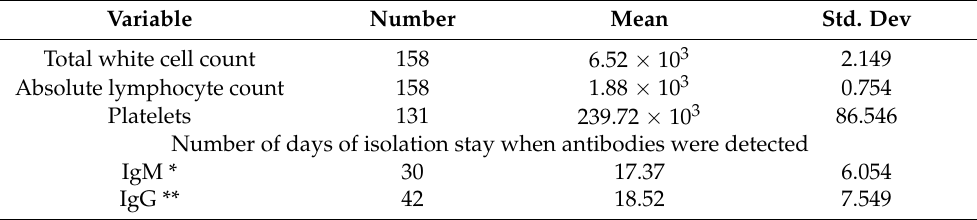
Table 2. Haematological and serological data of COVID-19 patients in Phuentsholing. Variable